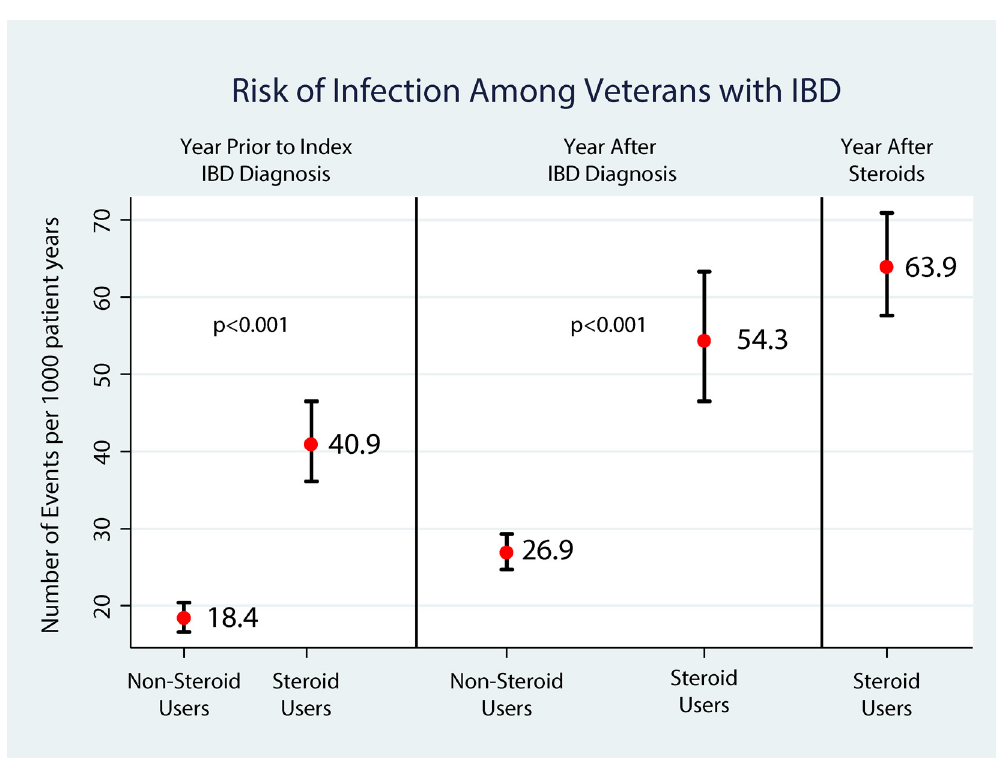
Fig 6. Risk of Infections among Veterans with IBD.